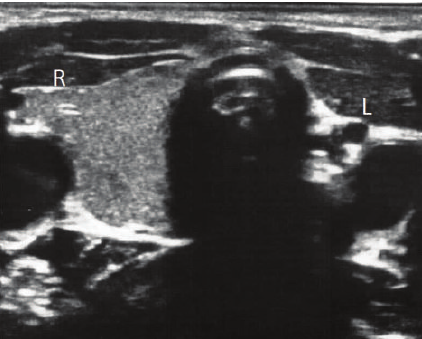
Figure 1: On transverse sonogram of the thyroid, right lobe (R) displaysnormal,homogeneousechotexturewithoutanynodule.Left lobe cannot be demonstrated. Strap muscles and vascular structures are displaced to fill the location of the left lobe (L).